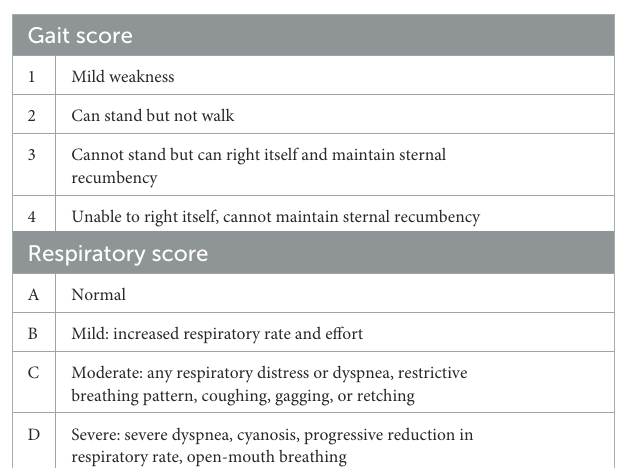
TABLE 1 Respiratory and gait scoring system for tick paralysis